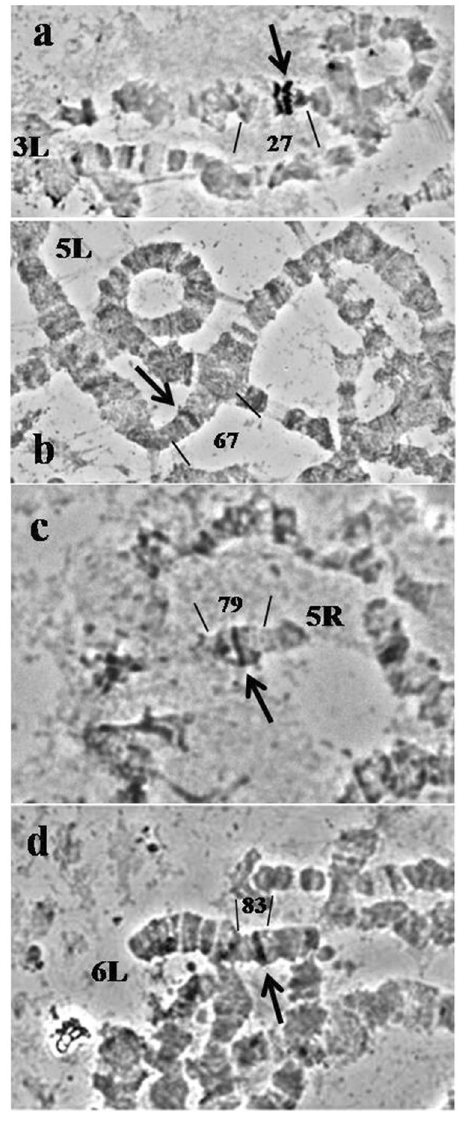
Figure 6. In situ hybridization on the salivary gland polytene chromosomes of Ceratitis fasciventris . ( a ) hybridization site of the hsp70 probe; ( b ) hybridization site of the w probe; ( c ) hybridization site of the sxl probe and ( d ) hybridization site of the st probe. Arrows indicate the hybridization